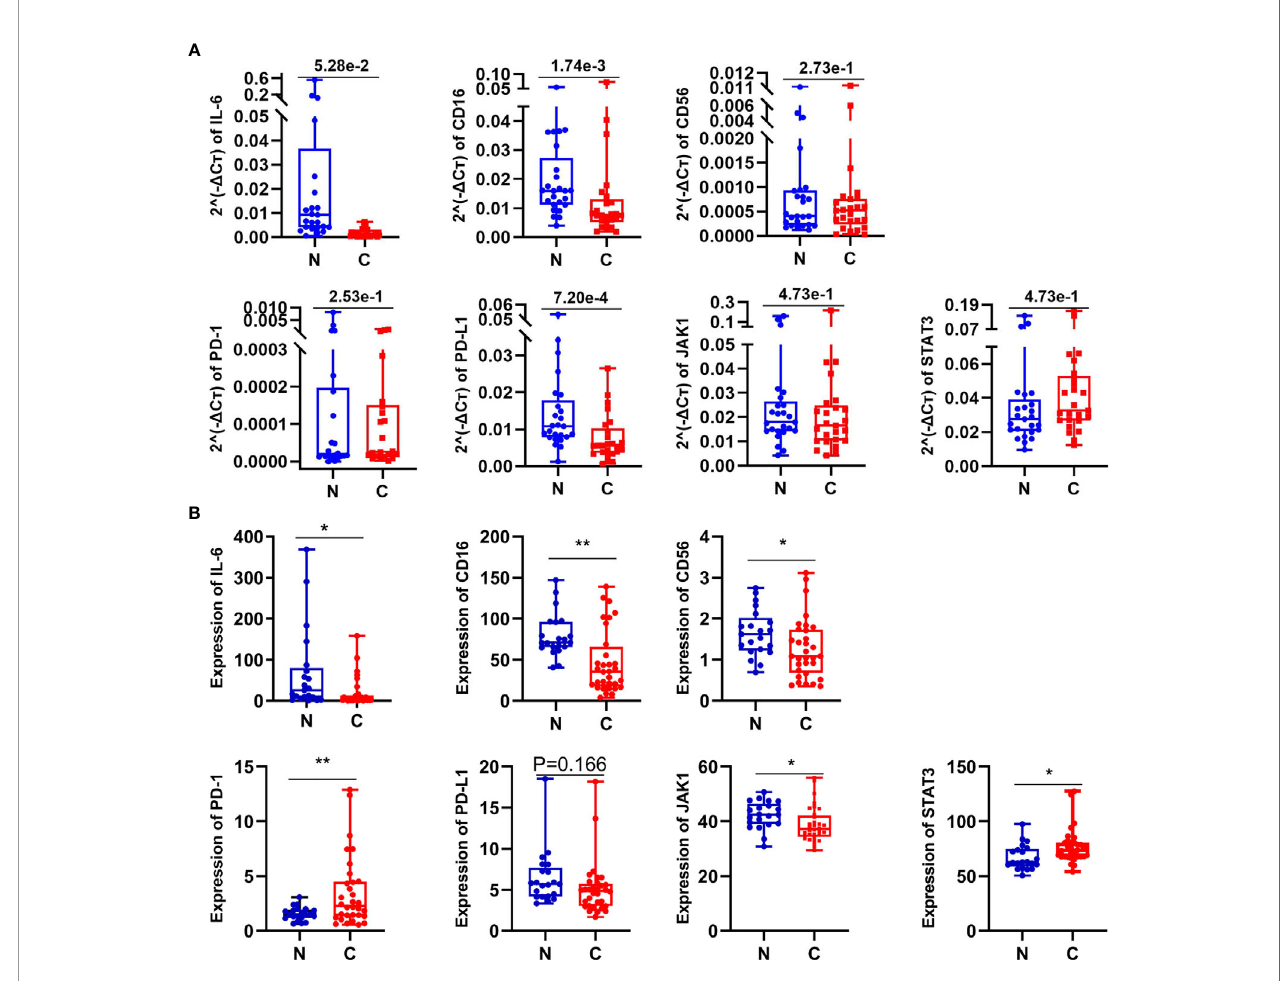
FIGURE 5 | The expression of some related molecules in lung GGO tissues. (A) Relative expression of seven genes in 25 paired normal and cancer tissues by qPCR. (B) The expression of seven genes re fl ected by RNA-seq data come from 21 GGO patients. Each dot represents an individual patient. Results are expressed as mean ± SEM. *P < 0.05; **P < 0.01. N, normal; C,